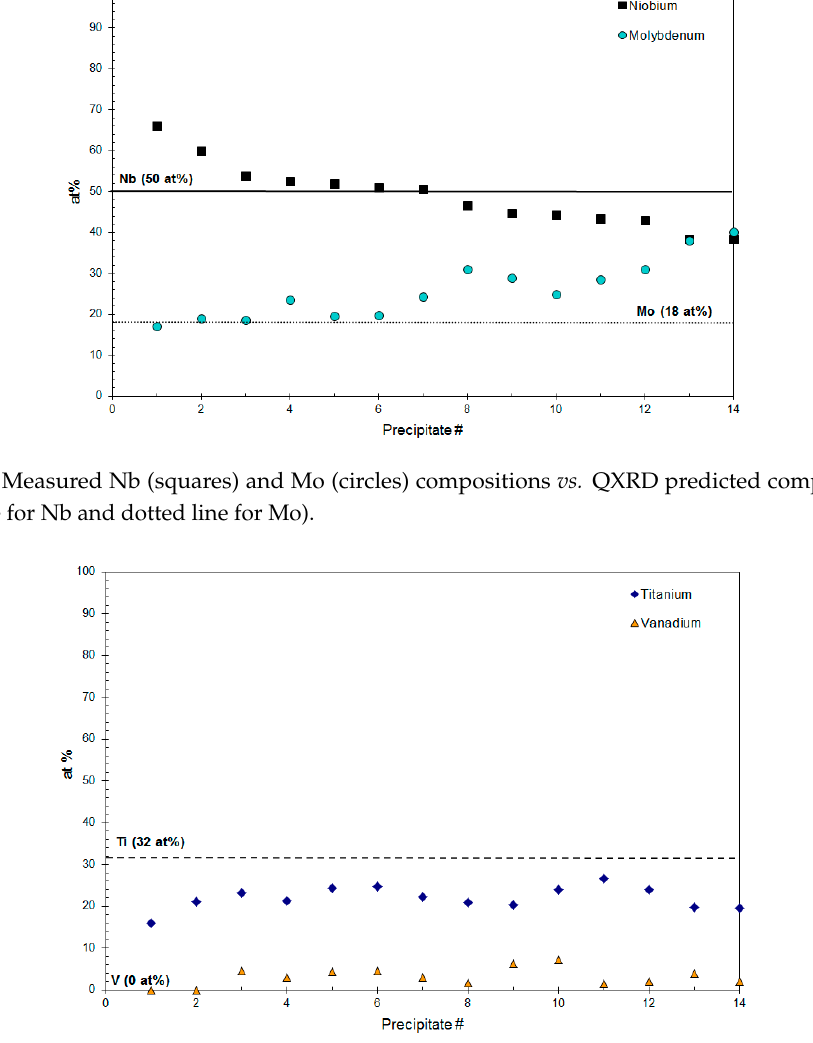
Figure 9. Measured Ti (diamonds) and V (triangles) compositions vs. QXRD predicted compositions (dashed line for Ti and 0 at% for V).